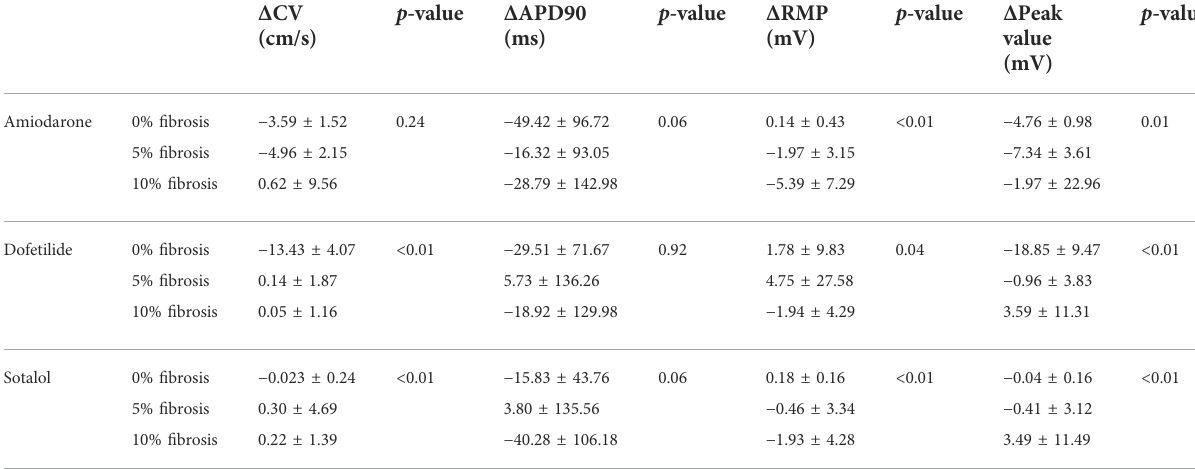
TABLE 3 Change in conduction velocity for the studied antiarrhythmic drugs under the effect of fi